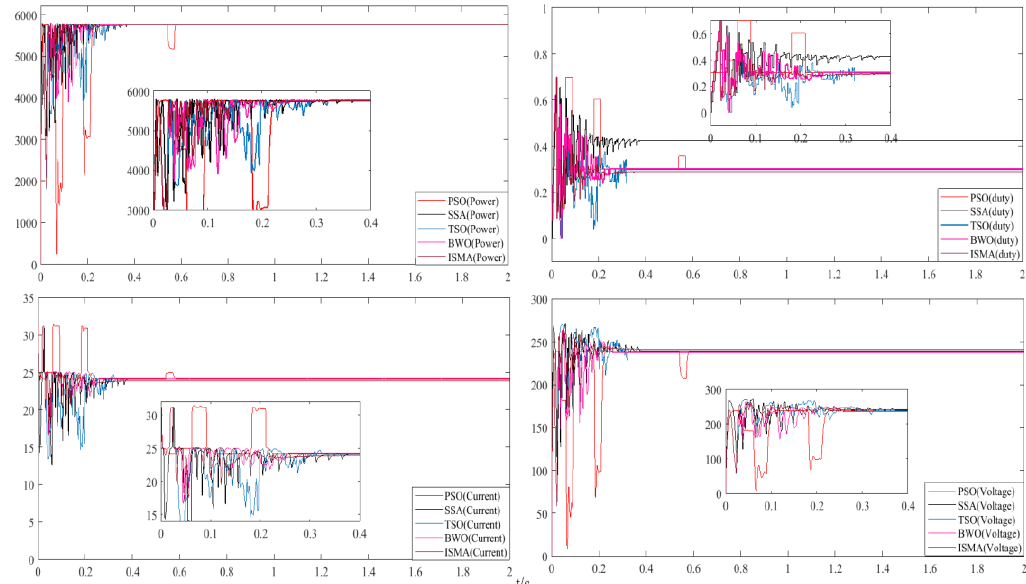
Figure 8. Output curves of five different algorithms under PSC1 conditions.